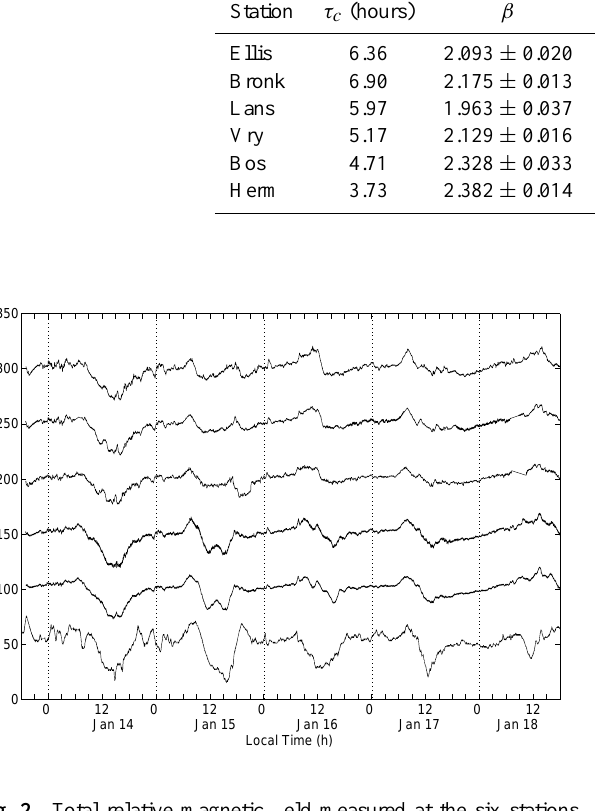
Fig. 2. Total relative magnetic field measured at the six stations from 13–18 January 1993. The series are plotted as a function of local time (LT) and range from top to bottom in increasing latitude. From top to bottom (1) Ellis, (2) Bronk, (3) Lans, (4) Vry, (5) Bos and (6) Herm.